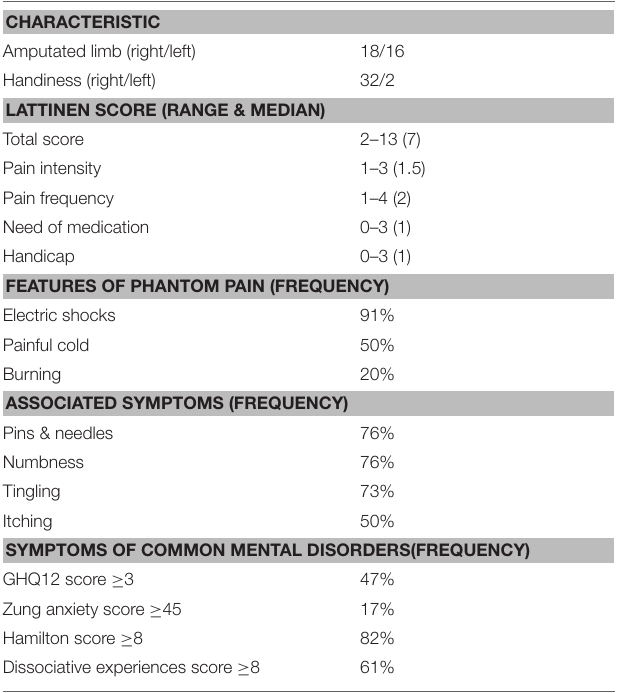
TABLE 1 | General characteristics of 34 patients with unilateral supracondylar amputation of a lower limb, secondary to type 2 diabetes mellitus.